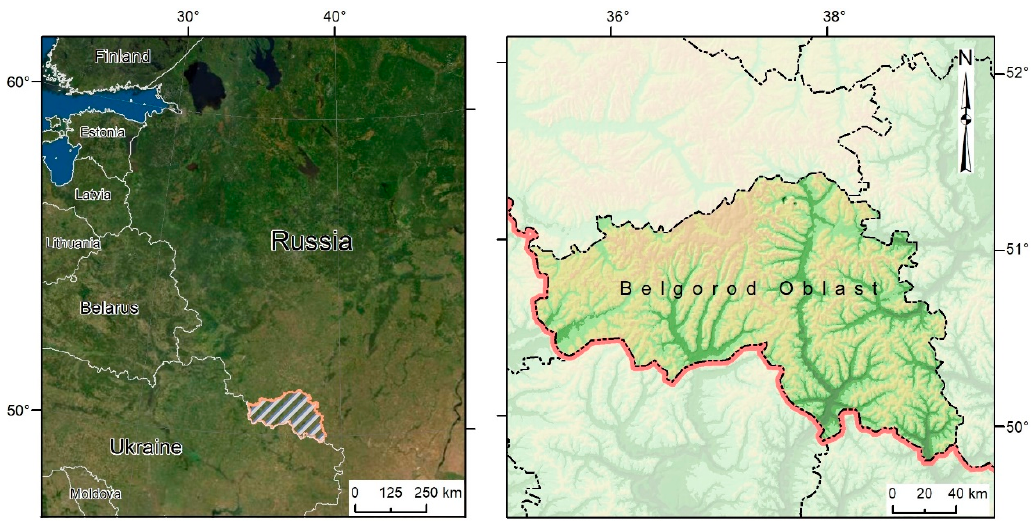
Figure 1. Location of the study area (Belgorod Oblast) in the East European Plain.